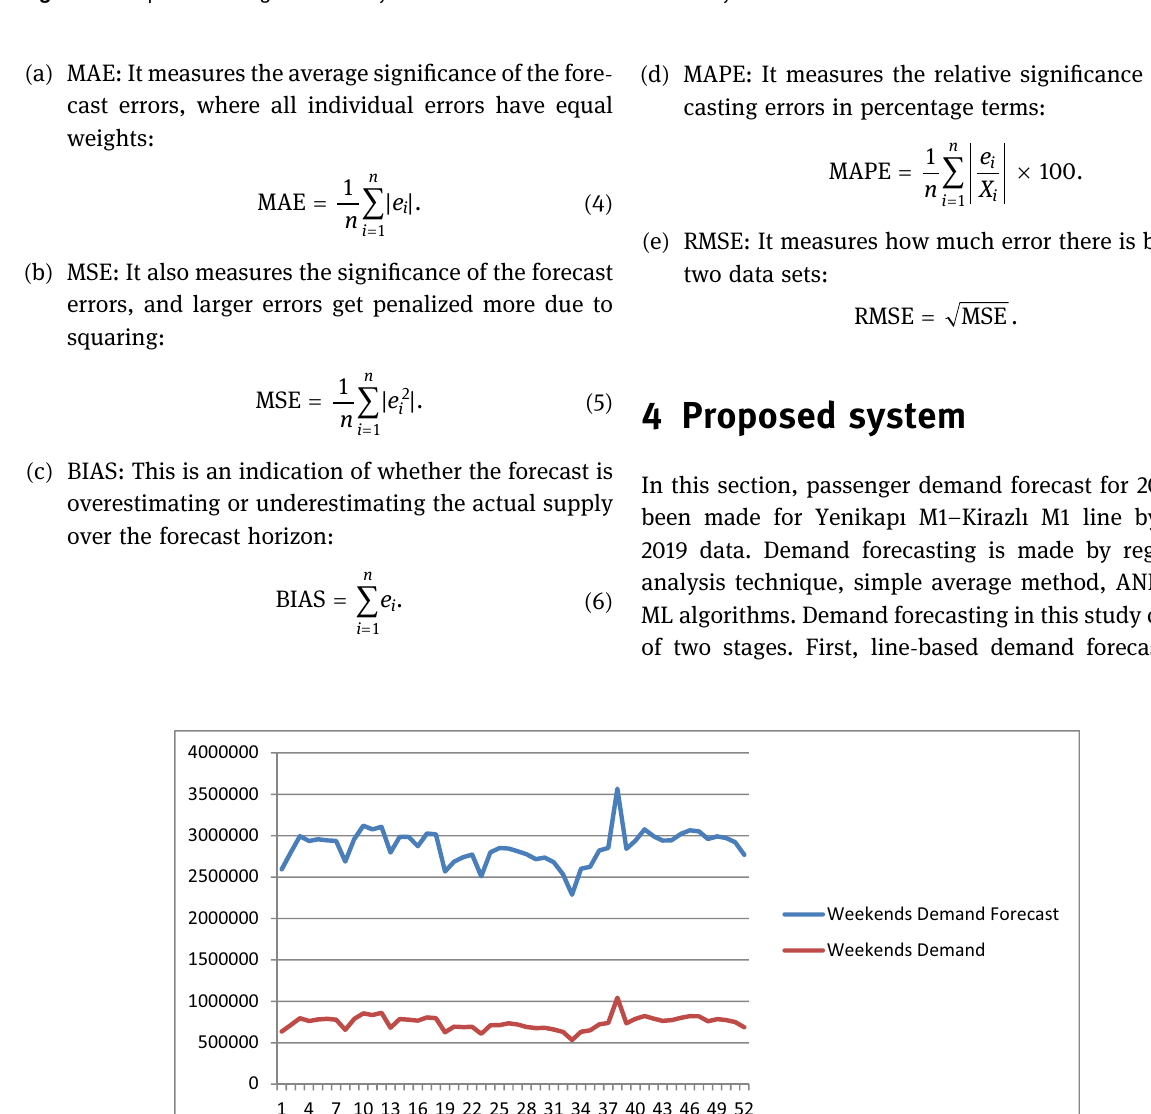
Figure 2: Comparison of regression analysis results and test values for weekdays.